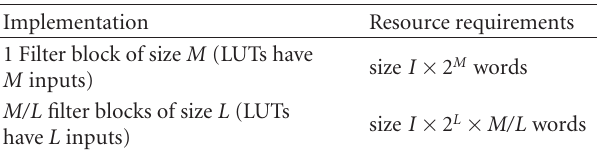
Table 1: Fir filter implementation savings due to the use of filter